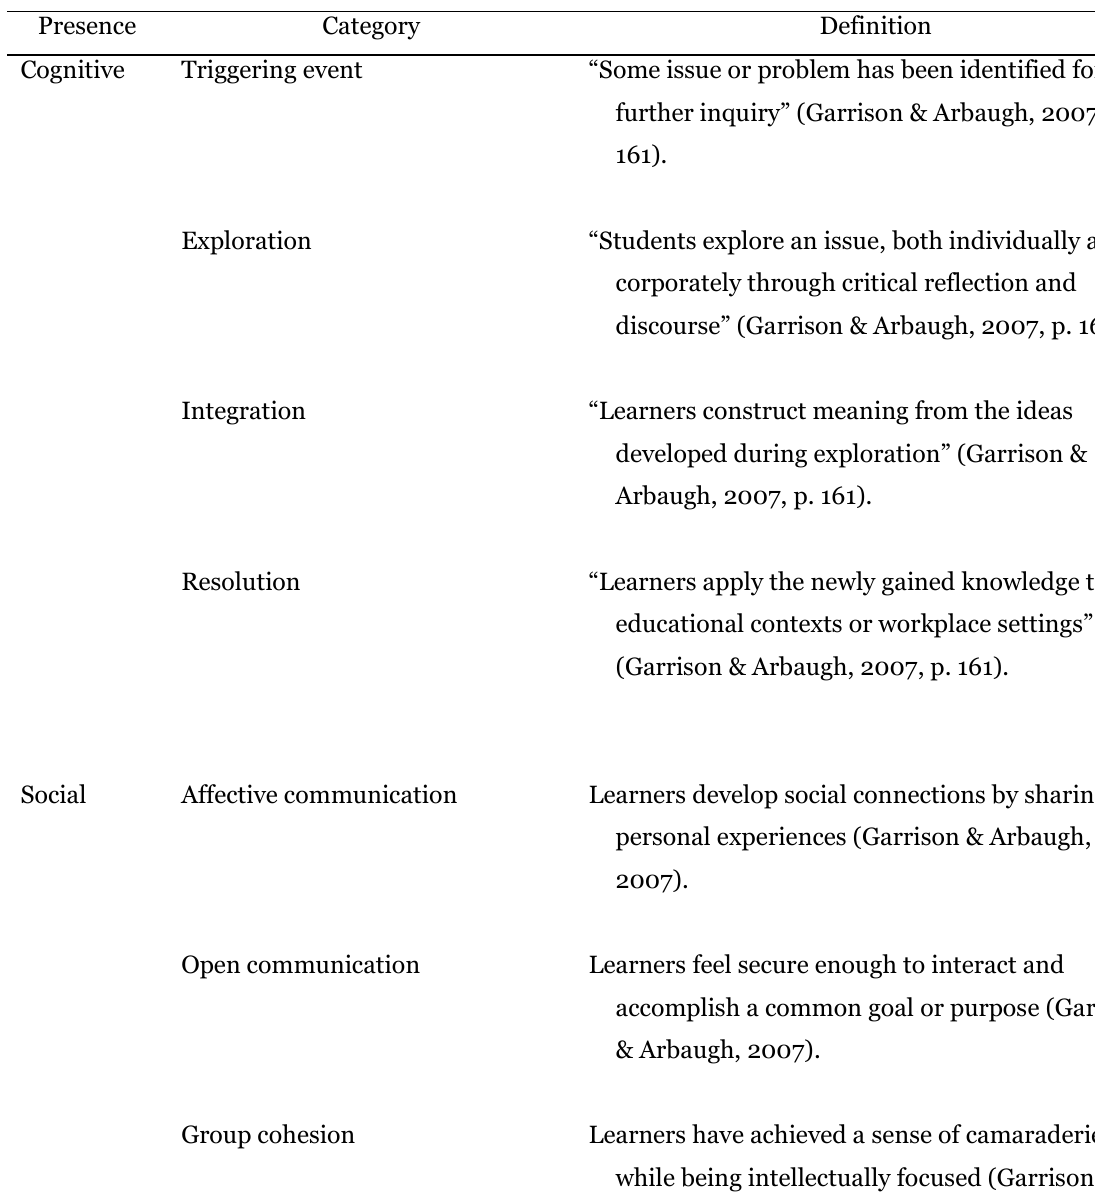
Summary of Categories Within the CoI